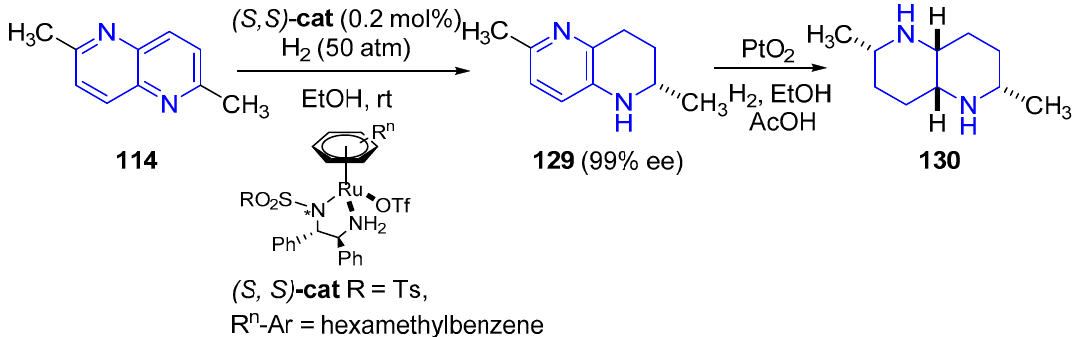
Scheme 53. Enatioselective reductions of